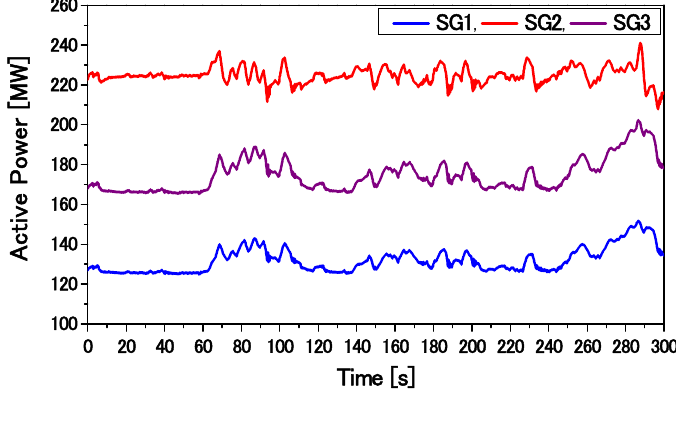
Figure 39. Active power output of SGs.